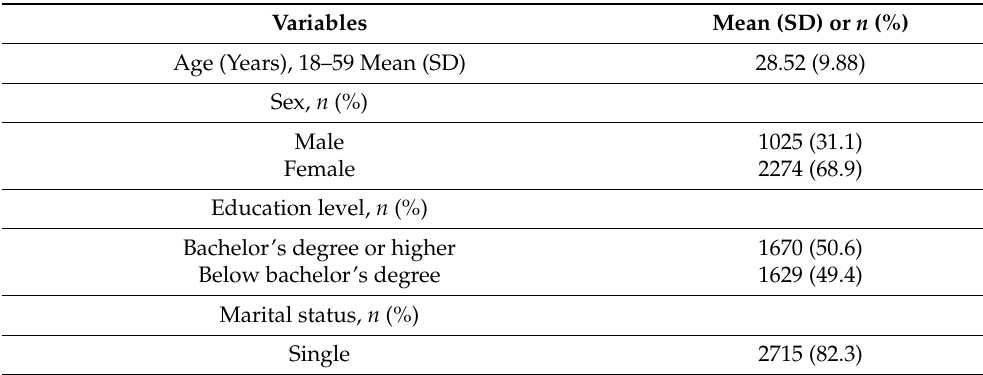
Table 1. Participant characteristics by percentage, mean and SD ( n =